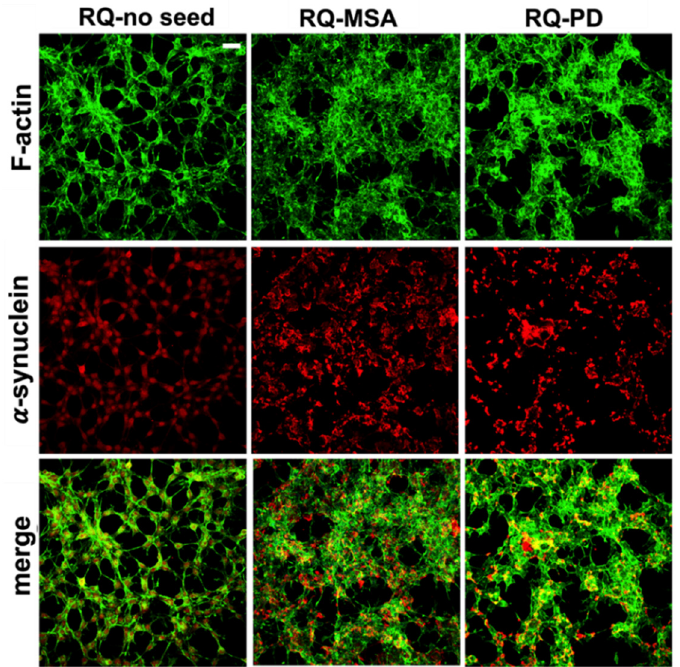
Figure 2. Intracellular α Syn aggregates in human differentiated neuroblastoma cells (SH-SY5Y) stimulated with RQ-MSA and RQ-PD. Representative pictures of SH-SY5Y cells incubated with RQ- MSA, RQ-PD (2.5 µM) or the unseeded α Syn_RT-QuIC reaction mix (RQ-no seed) were stained with mouse monoclonal antibody against α Syn (4D6), followed by Alexa Fluor-555 donkey anti-mouse secondary Abs (red) to show the presence of intracellular aggregates of α Syn. SH-SY5Y cells were counterstained with fluorescently-conjugated Alexa-Fluor 488-Phalloidin (green) to highlight the thin neurite-like cytoplasmic structures (cell-to-cell contacts) denoted by F-actin filaments. Scale bar = 25µm.